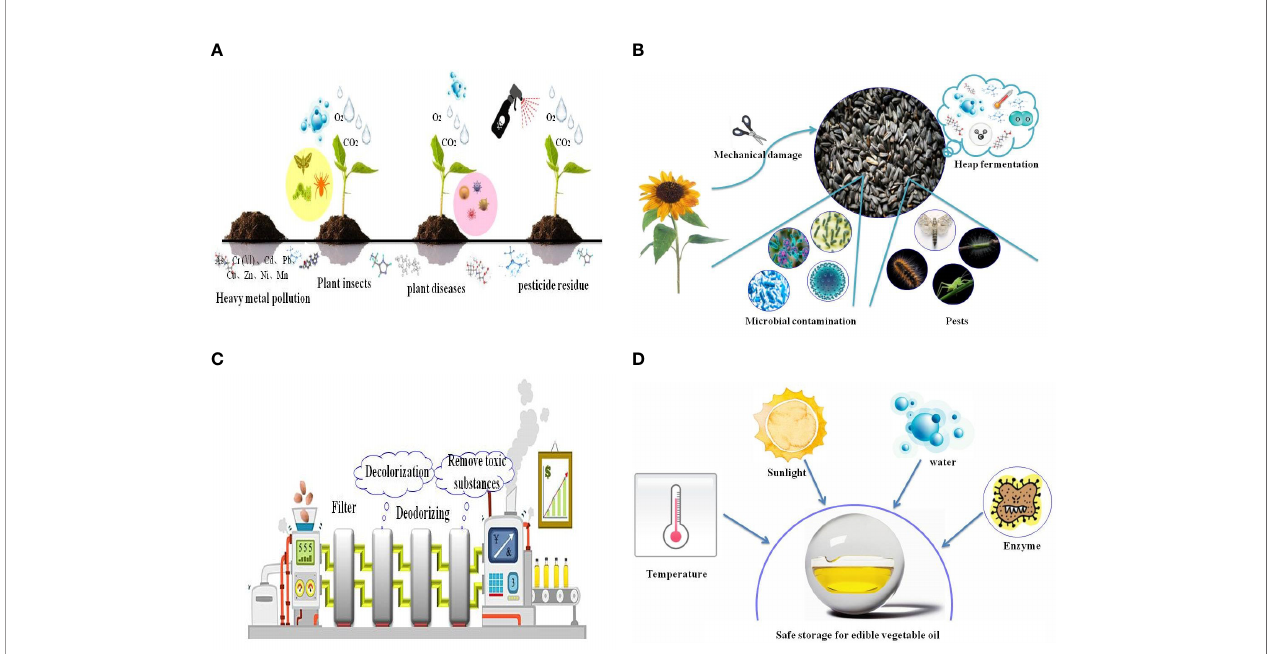
FIGURE 4 | Environmental risks in (A) oil-bearing plant cultivation, (B) the harvesting and post-harvest process of EPOs, (C) during EPO processing, and (D) during EPO storage. The graph takes sun fl ower seeds as an example to show the risks that oil crops will encounter during harvesting and post-harvesting process.